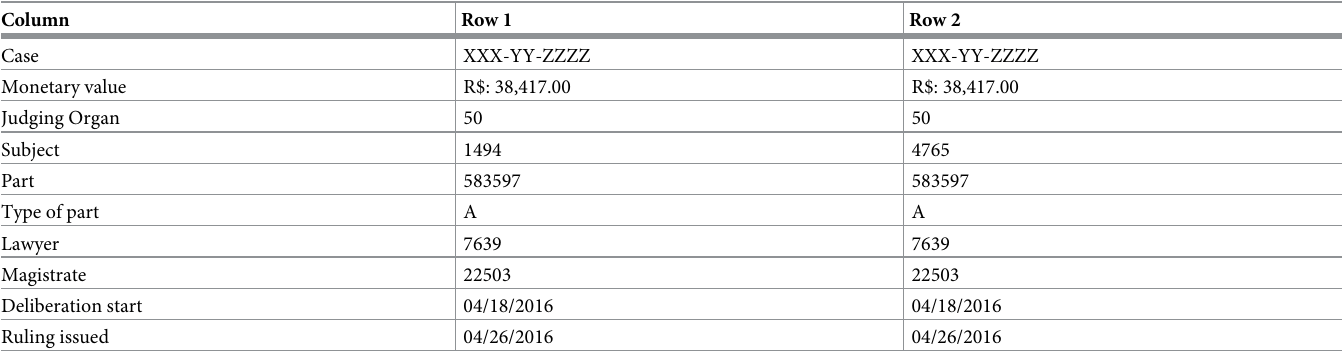
Table 2. Example of a case with repeated rows contained in the